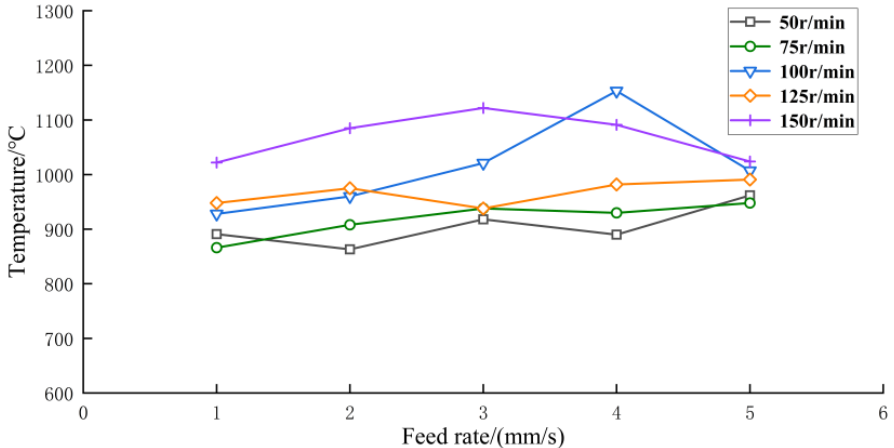
Figure 15. Variation of average temperature of sawtooth tip with feed rate and rotating